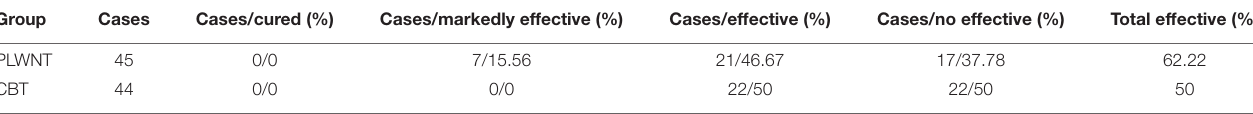
TABLE 2 | Efficacy evaluation of PLWNT group and CBT group after 12 weeks of intervention (Cases/effective rate). Group